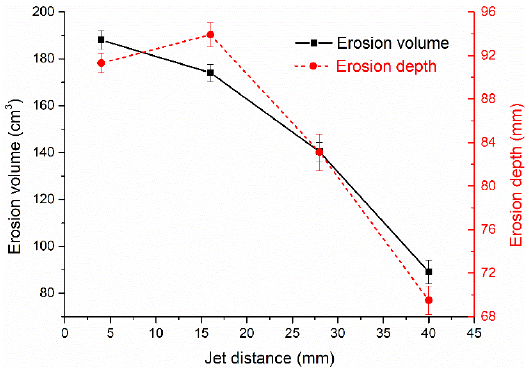
Figure 6. The influence of jet distance on erosion volume and erosion depth.